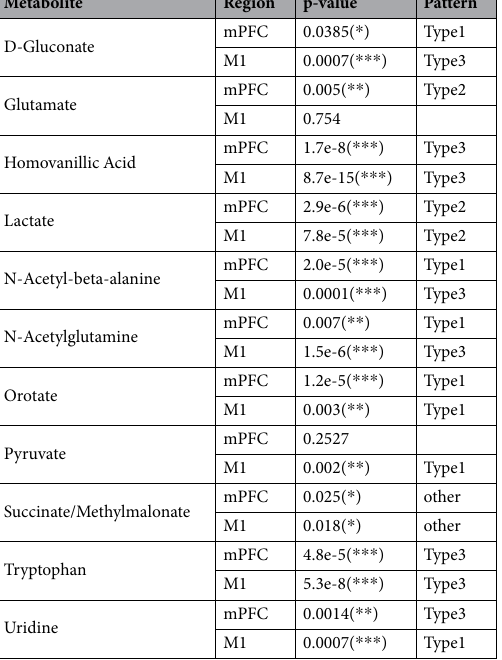
Table 3. Comparisons between early and late periods of spontaneous sleep and recovery sleep. Significance of condition * time interaction for each of the 11 significant compounds, in each region. For this analysis Time is a continuous covariate (linear). Condition is either “Early” (the first 3 hours of the S6 condition), “Late” (the last 3 hours of the S6 experiment) or Recovery (the 3 hours of sleep from the EW6-S3 experiment). Type 1: no significant difference between the conditions; Type 2: recovery sleep decreases significantly faster than early sleep; Type 3: early sleep decreases significantly faster than recovery sleep. ( * )p < 0.05, ( ** )p < 0.01, ( *** )p < 0.001.